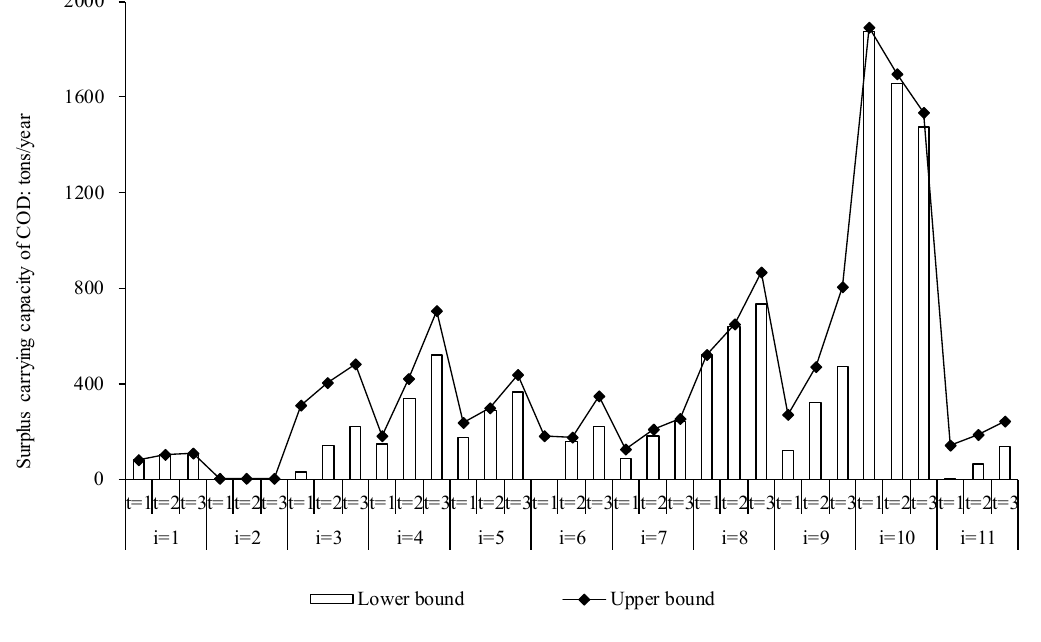
Figure 11. Surplus COD carrying capacity for the Yinma River.